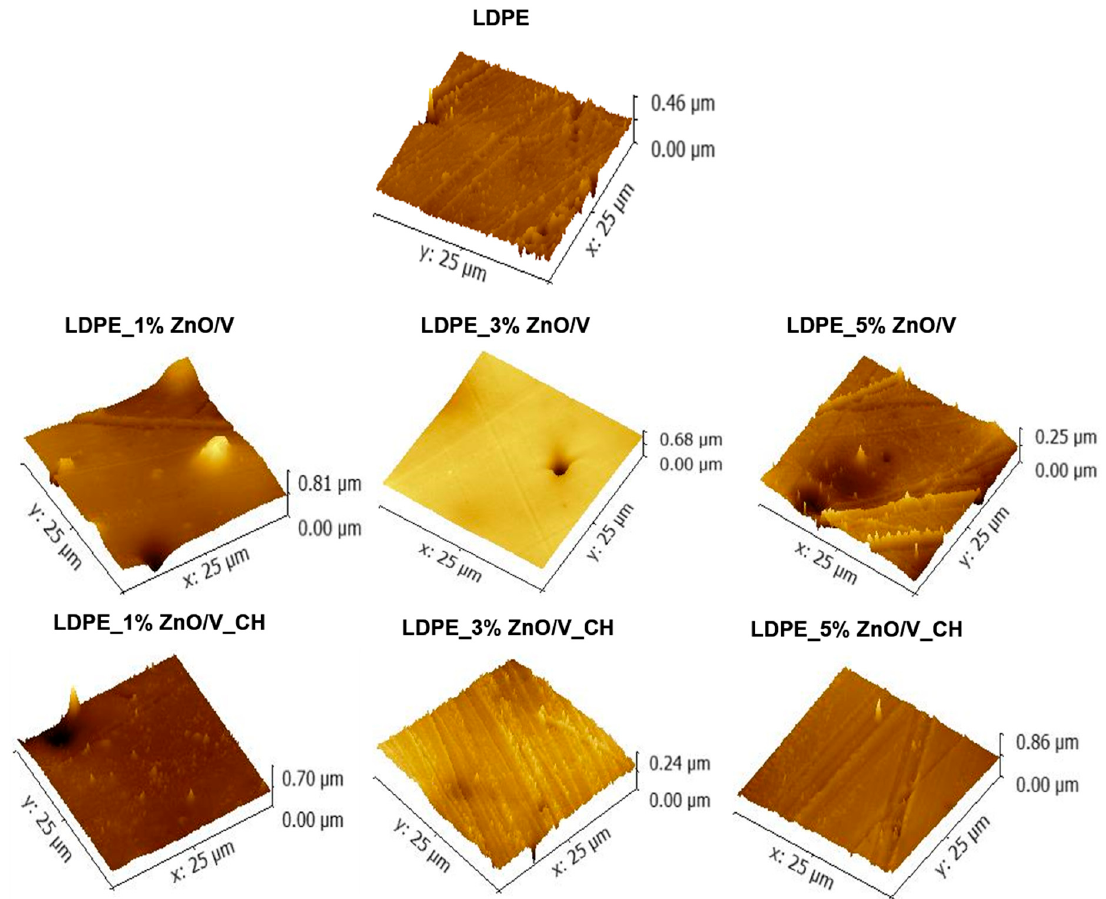
Figure 7. 3D AFM images of the natural LDPE surface and LDPE_1% ZnO/V, LDPE_3% ZnO/V, ZnO / V, LDPE_5% ZnO / V, LDPE_1% ZnO / V_CH, LDPE_3% ZnO / V_CH and LDPE_5% ZnO / V_CH LDPE_5% ZnO/V, LDPE_1% ZnO/V_CH, LDPE_3% ZnO/V_CH and LDPE_5% ZnO/V_CH nanocomposite nanocomposite surfaces.